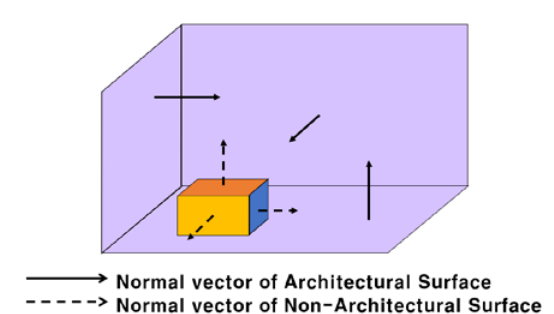
Figure 8. An example of TMD file format